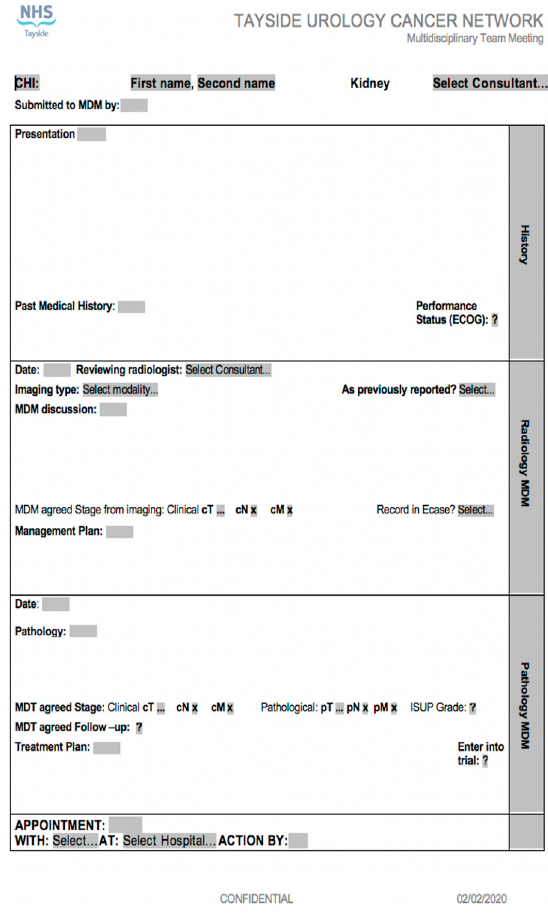
Figure A1. Proforma.